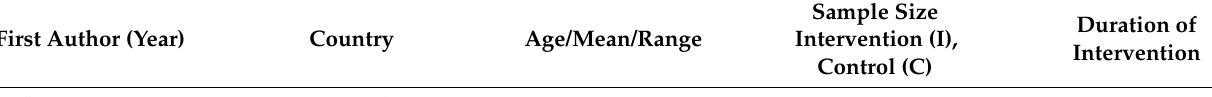
Table 1. Characteristics of the